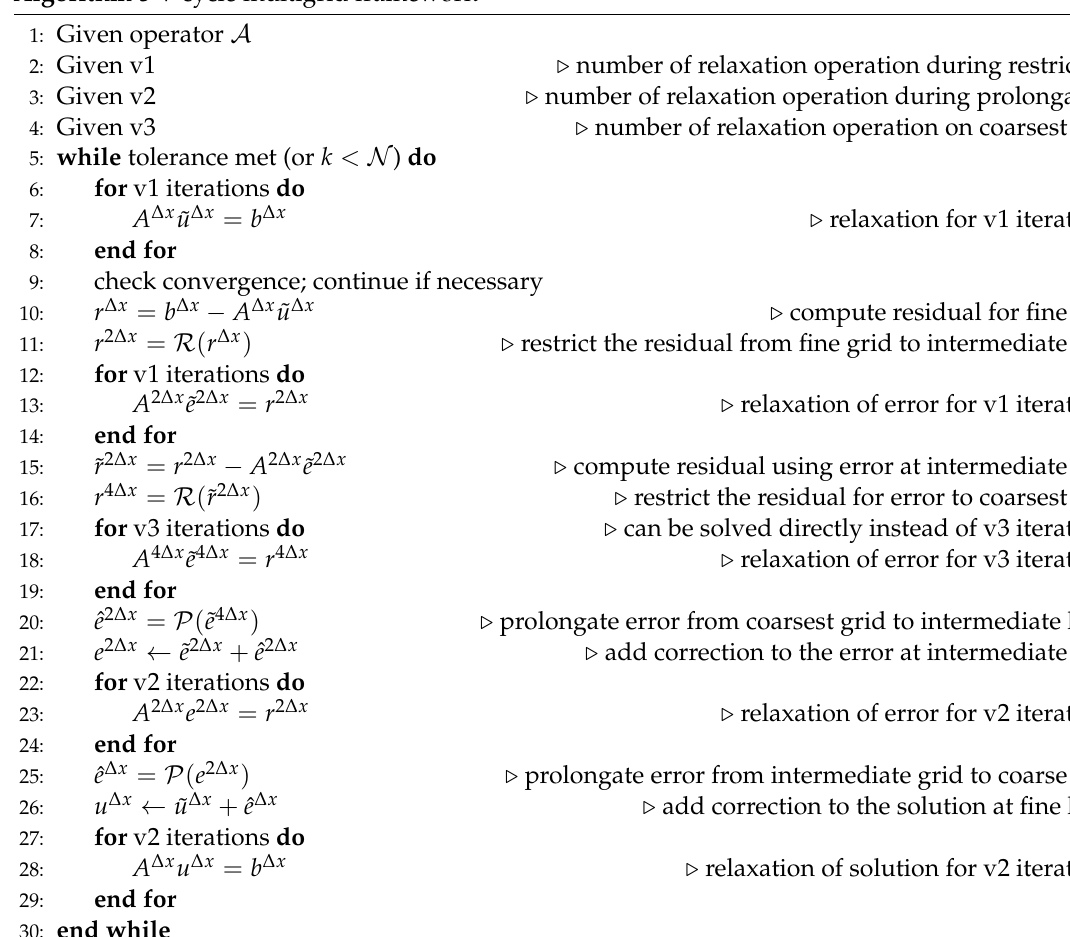
Algorithm 5 V-cycle multigrid